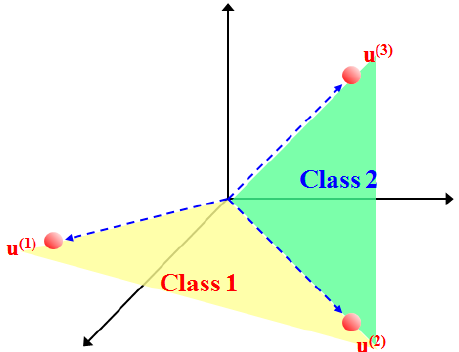
Figure 2. Illustration of subspace projection under the linear mixture model assumption, where { t u p 1 q , u p 2 q , u p 3 q u denote the spectral endmembers. The colored spaces are the class-dependent subspaces spanned by t u p 1 q , u p 2 q , u p 3 q u